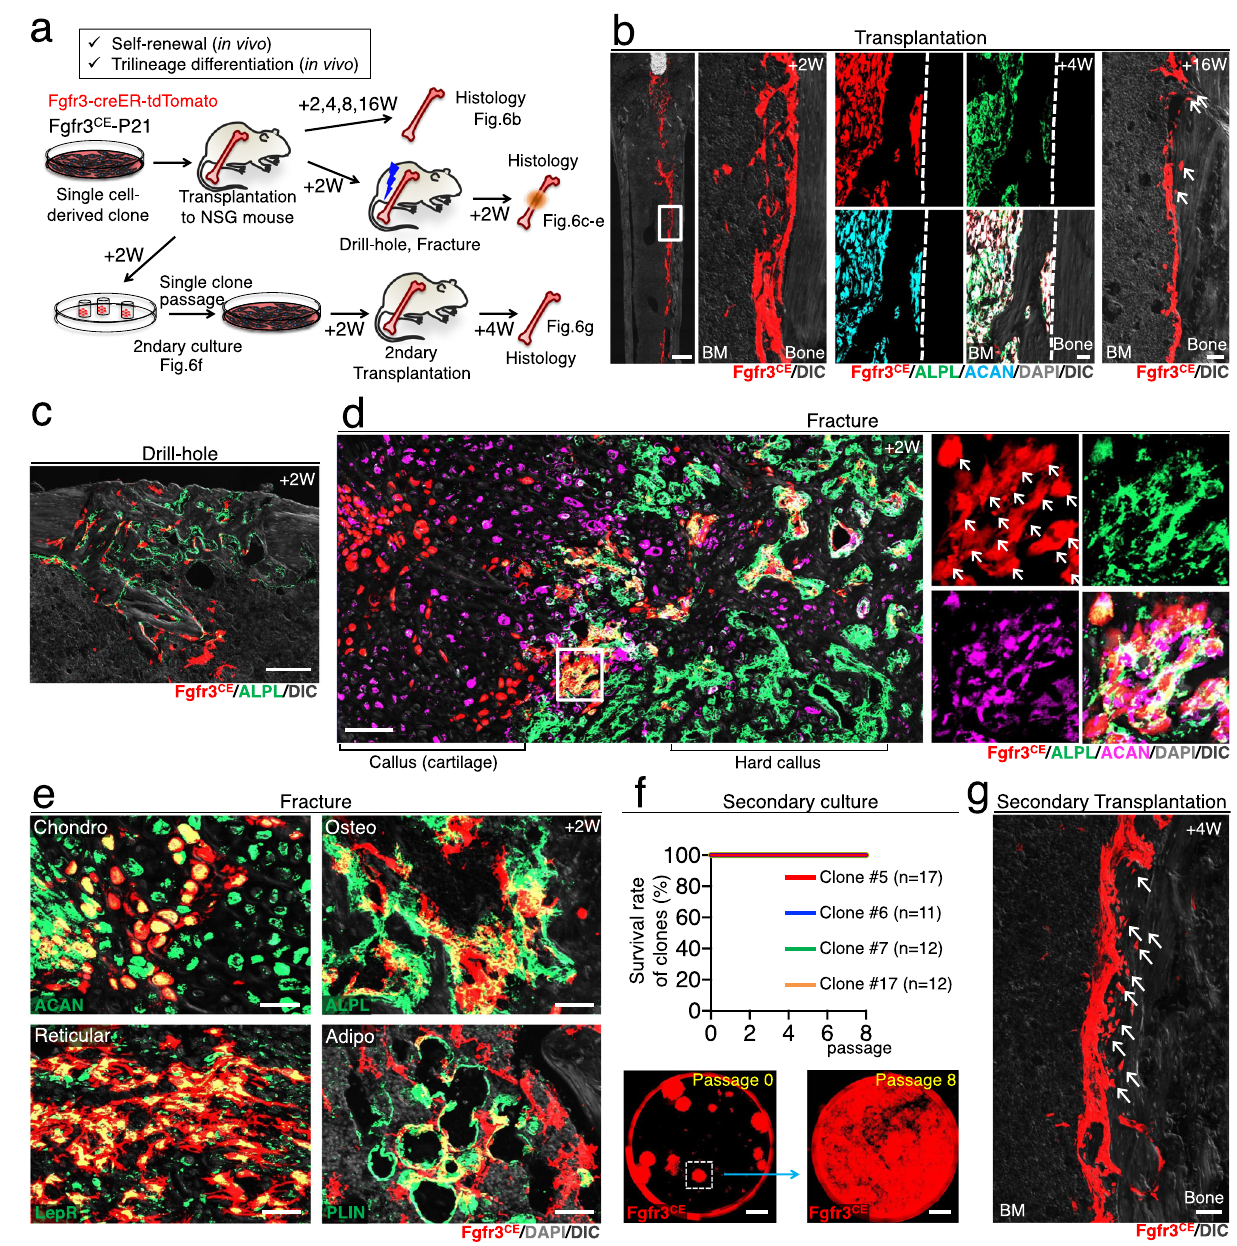
Fig. 6 | Self-renewal and trilineage potential of Fgfr3 + endosteal stem cells in transplantation. a Diagram of transplantation experiments of ex vivo expanded single cell-derived Fgfr3 + endosteal stem cells, involving NSG recipient mice, sub- sequent surgeries, secondary CFU-F, and transplantation assays. b NSG recipient femur transplanted with Fgfr3-creER + endosteal stem cells after 2 weeks (left), 4 weeks with ALPL and ACAN staining (center), and 16 weeks (right). Scale bar: 500 µ m (left), 20 µ m (center), 40 µ m (right). n =4 clones. c Drill-hole injury of NSG recipient mice transplanted with Fgfr3-creER + stem cells, at 2 weeks after surgery with ALPL staining. Scale bar: 200 µ m. n =4 clones. d , e Complete fracture of NSG recipient mice transplanted with Fgfr3-creER + stem cells, at 2 weeks after fracture